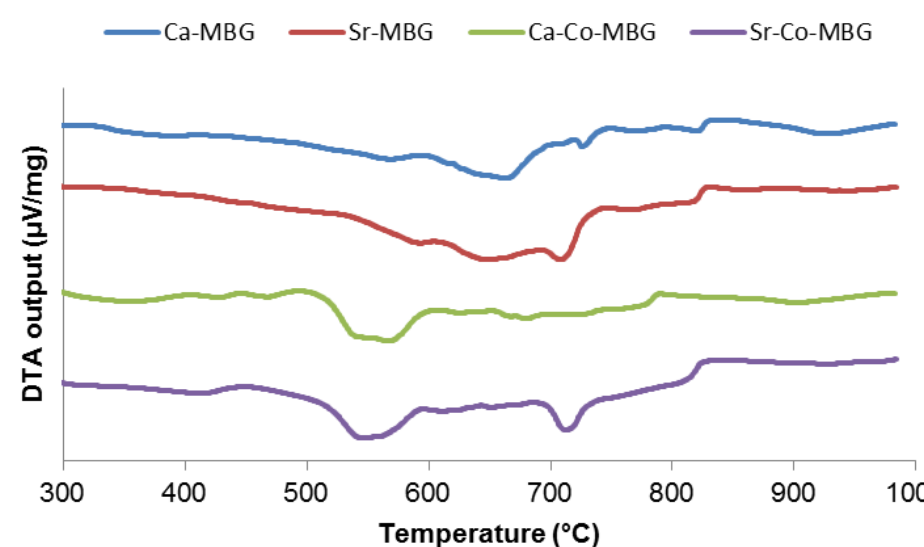
Figure 1. DTA plots resulting from thermal characterization of the gels.